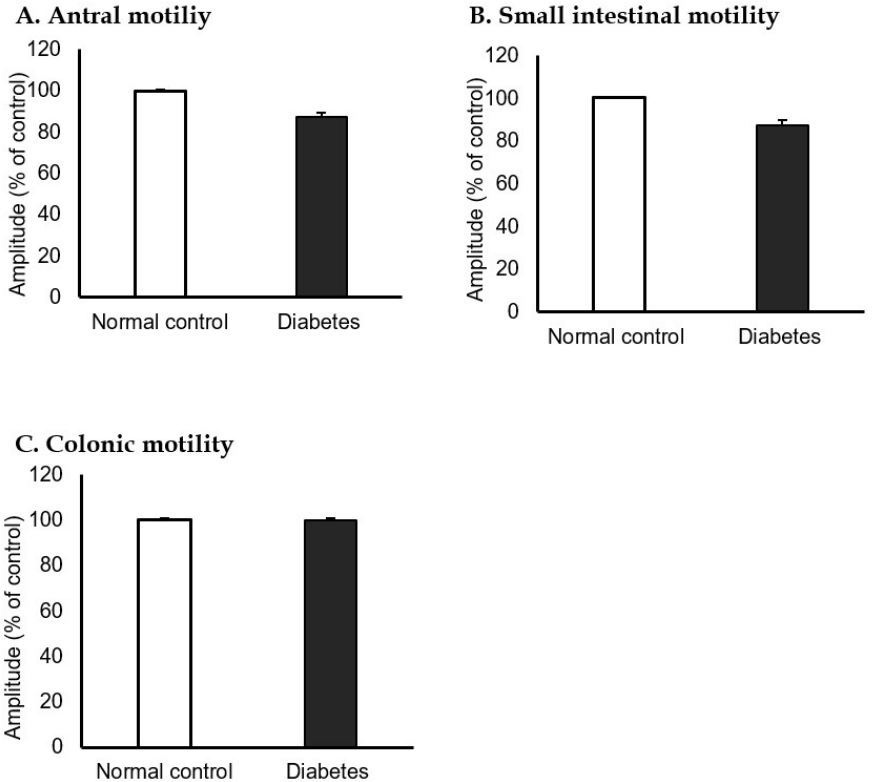
Figure 5. Antral, small intestinal, and colonic motility in normal control and streptozotocin-induced diabetic mice. The isometric contractions of each ( A ) antrum and ( B ) small bowel were significantly decreased in the streptozotocin-induced diabetic group compared to the normal control group (100% vs. 87.4%, 100% vs. 87.4%). ( C ) Colonic motility was not different between the normal control and diabetic group (100% vs. 100%). (n = 10 in each group).